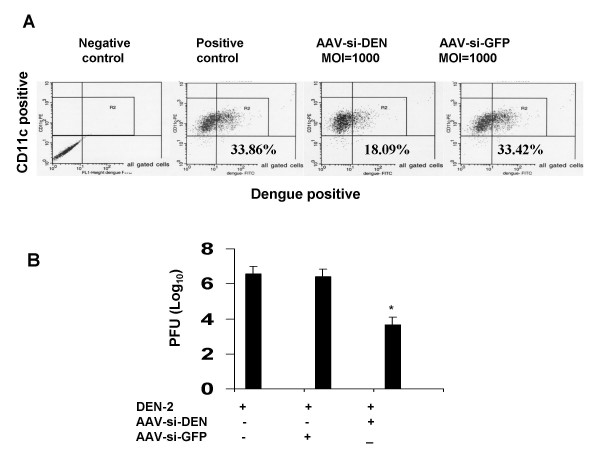
Suppression of DEN-2 replication in DCs by siDEN. (A) DCs were isolated from human peripheral blood and cultured in DMEM medium supplemented with FBS, IL-4 and GM-CSF. Non-adherent DCs were harvested on day 7, infected with AAVsiDEN, and two days later the cells were infected with DEN-2 at 0.1 MOI. DCs were harvested 5 days after DEN-2 infection and DEN-2 titers were measured by flow cytometry. (B) Supernatants from DEN-infected DCs were collected and added to culture plates containing confluent Vero cell monolayers. After virus adsorption, the Vero cells were overlaid with agarose and stained with 1% neutral red. Viral plaques were counted 48 h after neutral red overlay. Data are the averages of two independent experiments. *p < 0.05 compared to control.